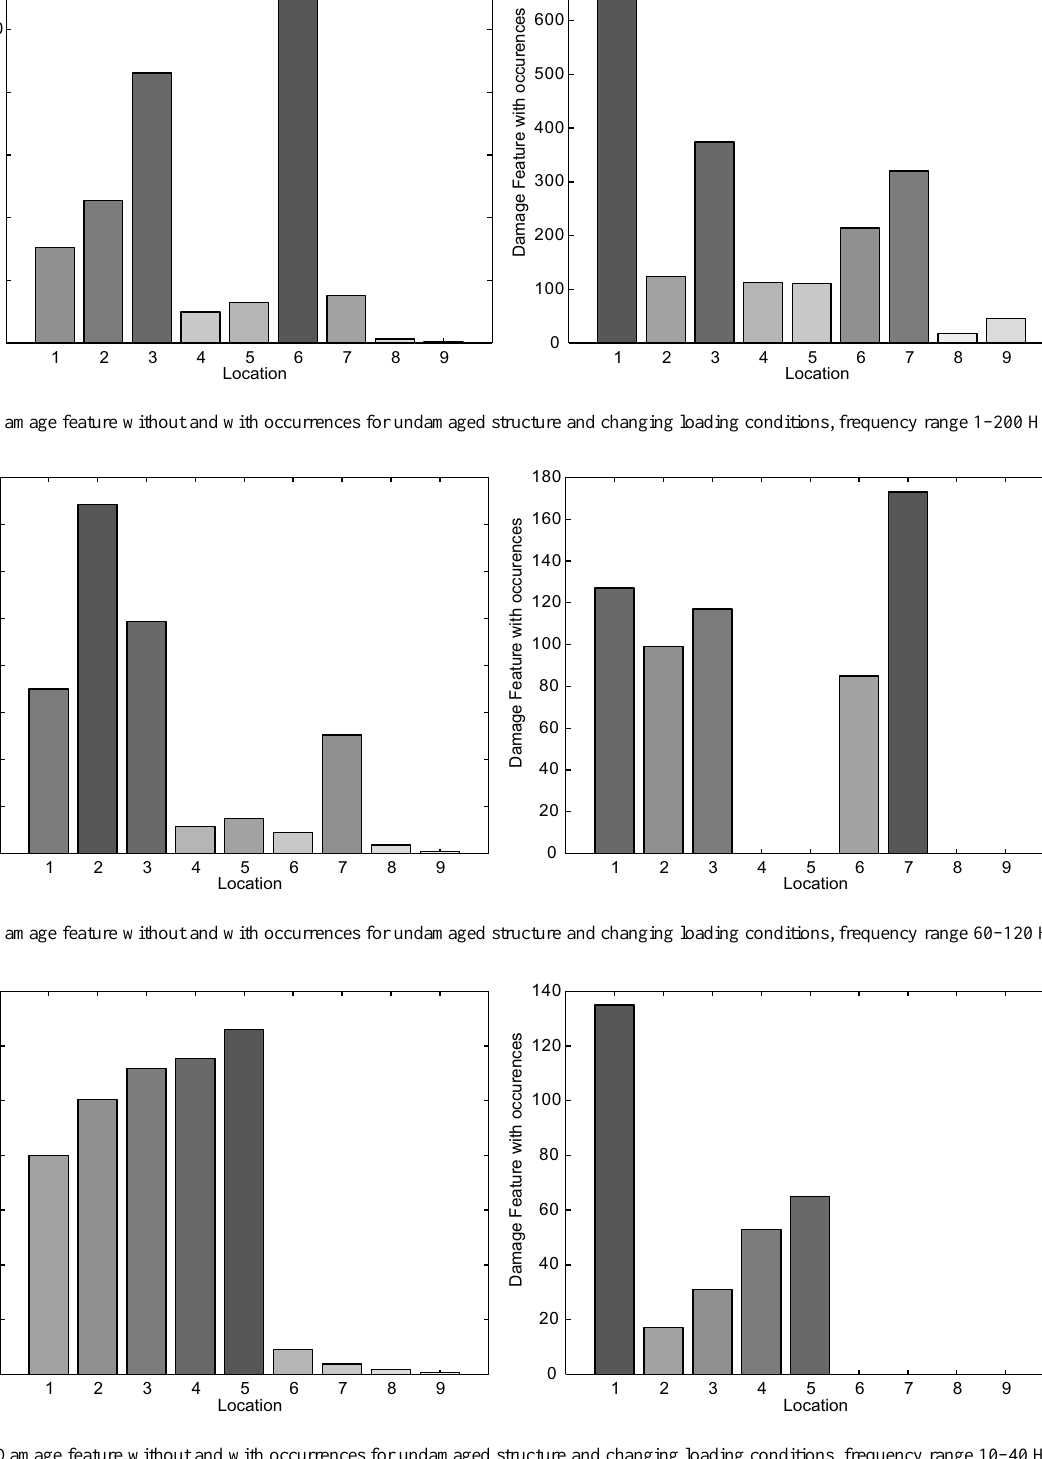
Fig. 11. Damage feature without and with occurrences for undamaged structure and changing loading conditions, frequency range 10–40